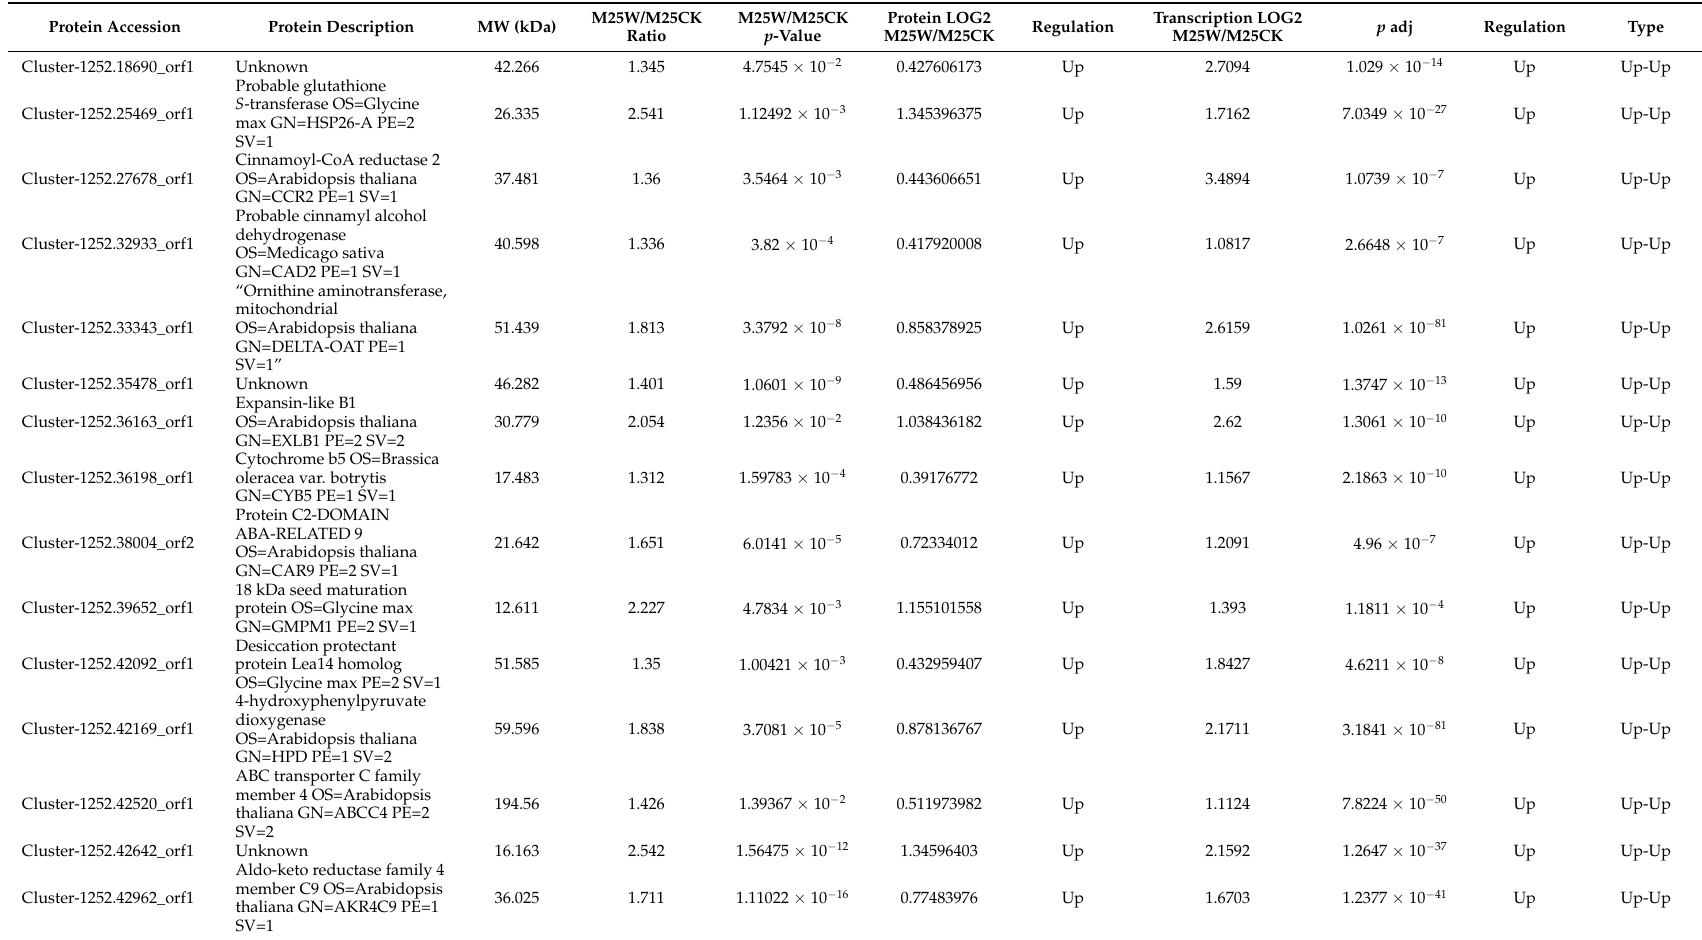
Table 5. Differentially abundant transcripts both at proteomic and transcriptomic levels in M25 under